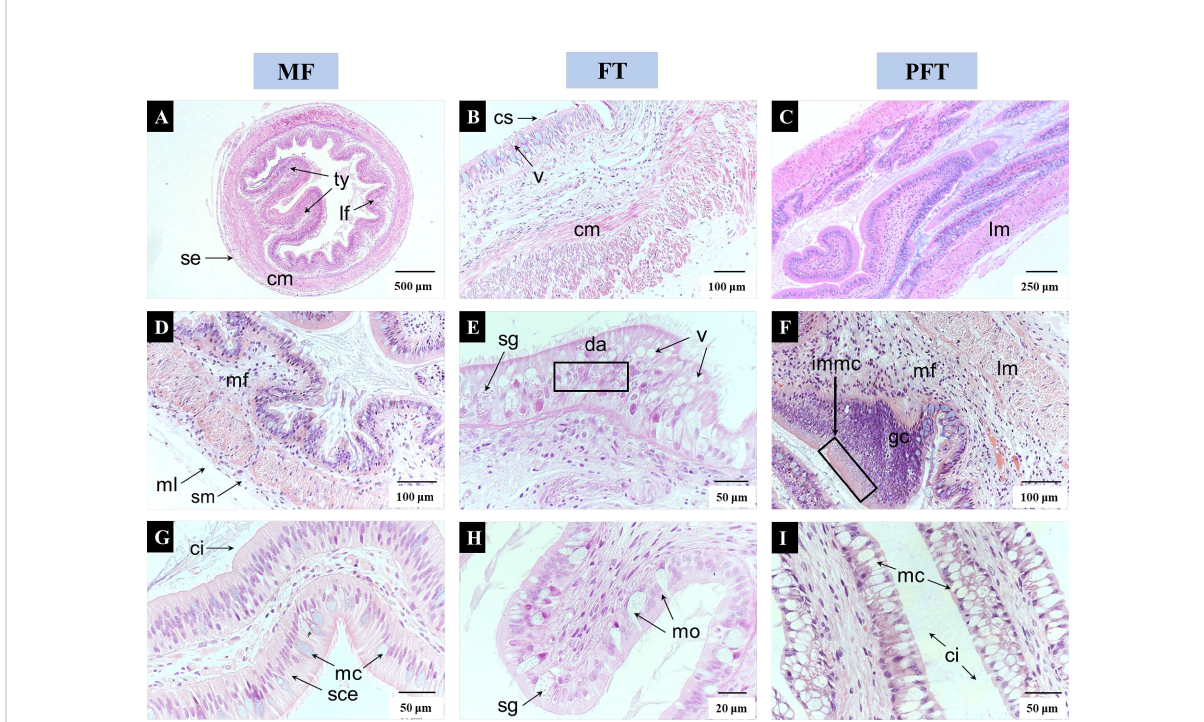
FIGURE 3 Light microscopic images depicting morphological changes in intestine associated to feed transition with 20 DPH (A, D, G) , 40 DPH (B, E, H) , and 60 DPH (C, F, I) . Panoramic view of the intestine at 20 DPH, showing the serosa (se) located in the epidermis, circular muscle (cm) and longitudinal muscle (lm) are closely attached, typhlosoles (ty) and longitudinal folds (lf) extend to the cavity. A transverse section of the intestine at 40 DPH, showing some cilia appeared to shedding (cs), columnar epithelium formed vacuoles (v) and epithelium cells were disordered arrangement (da). A transverse section of the intestine at 60 DPH, showing numerous goblet cells were accumulated and accompanied by many immature mucous cells (immc), columnar epithelial mucous cells are increased, and cilium are markedly height. ci, cilia; cm, cilia shedding; cs, cilia shedding; da, disordered arrangement; gc, goblets cells; immc, immature mucous cells; lf, longitudinal folds; lm, longitudinal muscle; mc, mucous cell; ml, mucous layer; mo, mucous out fl ow; sce, single columnar epithelium; se, serosa; sg, secretory granules; sm, submucosa; ty, typhlosoles; v, vacuole.